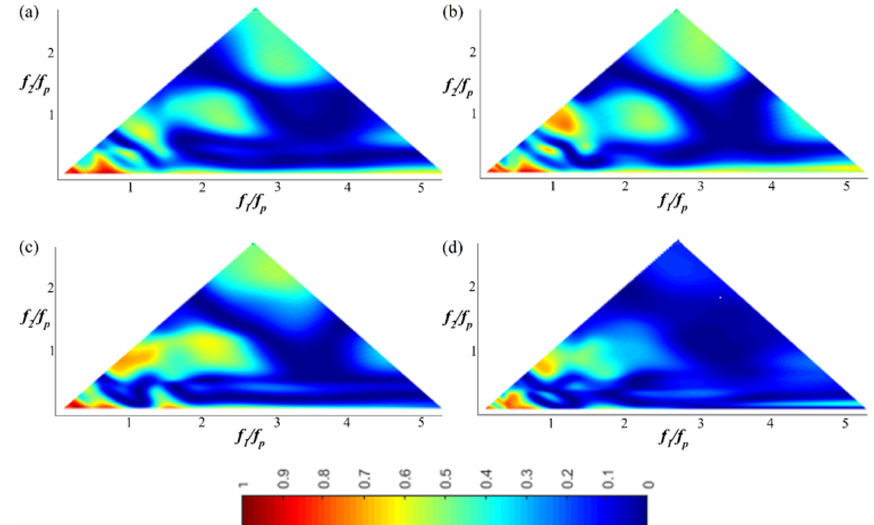
Figure 8. The wavelet-based bicoherence spatial evolution on the sloping bottom for the JONSWAP ( γ = 3 . 3) wave train (Test 5). (a) x = 10 . 20m; (b) x = 11 . 20m; (c) x = 12 . 40m; (d) x = 13 .